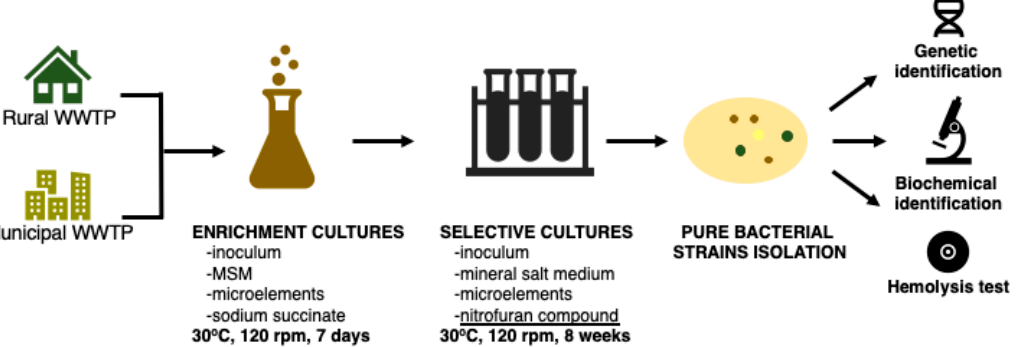
Figure 2. Isolation of microorganisms from the activated sludge—scheme of the procedure.